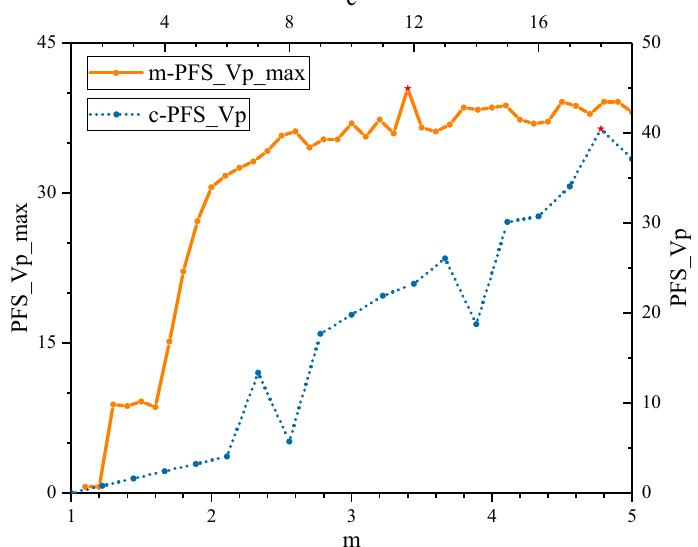
Figure 11. The relationship curve among fuzzy coefficient, cluster number, and comprehensive evaluation index.